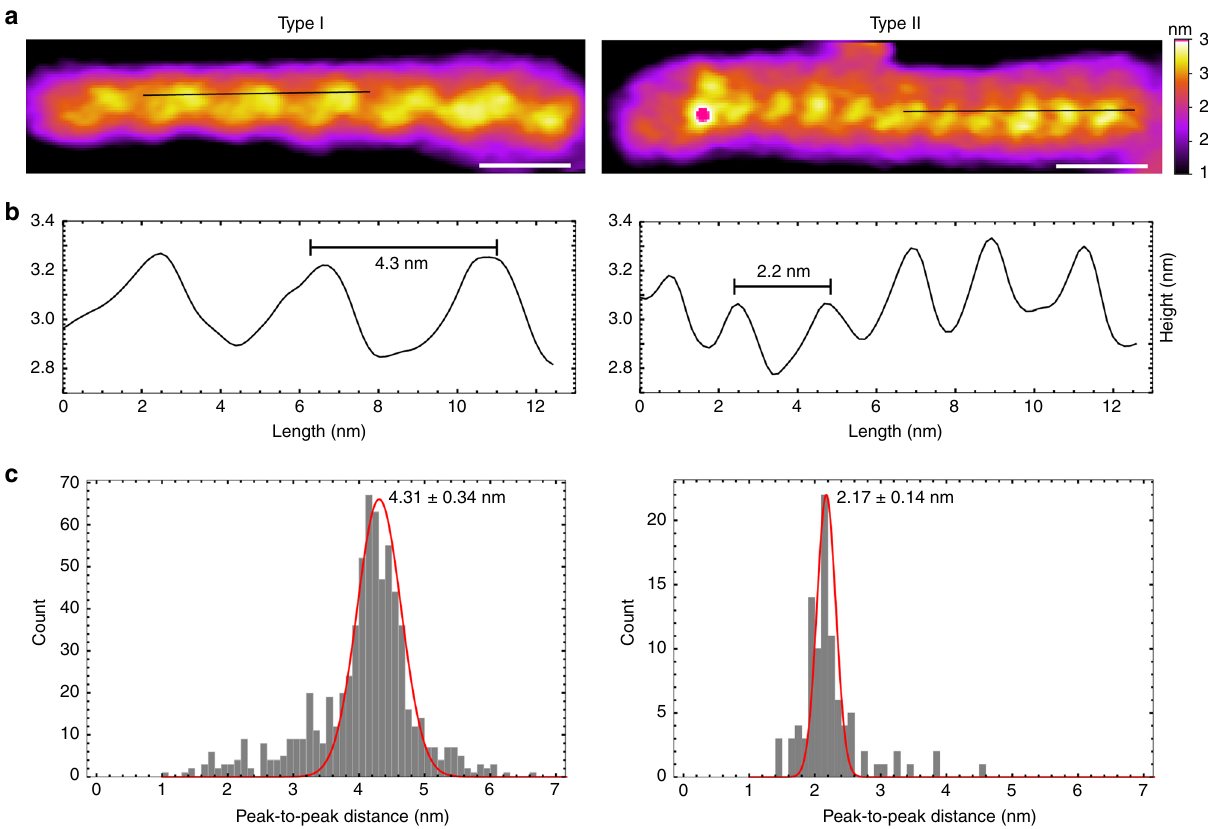
Fig. 2 Major types of G-wires. a AFM images and b height pro fi les (under the black lines) of Type I and Type II G-wires showing periodic ridges (peaks) separated by 4.3 and 2.2 nm, respectively. The length scale (white bar) is 5 nm. c Histograms of peak-to-peak distances fi tted with Gaussian indicate periodicity of 4.31 ± 0.34 and 2.17 ± 0.14 nm for Type I (100 molecules) and Type II (10 molecules) G-wires, respectively